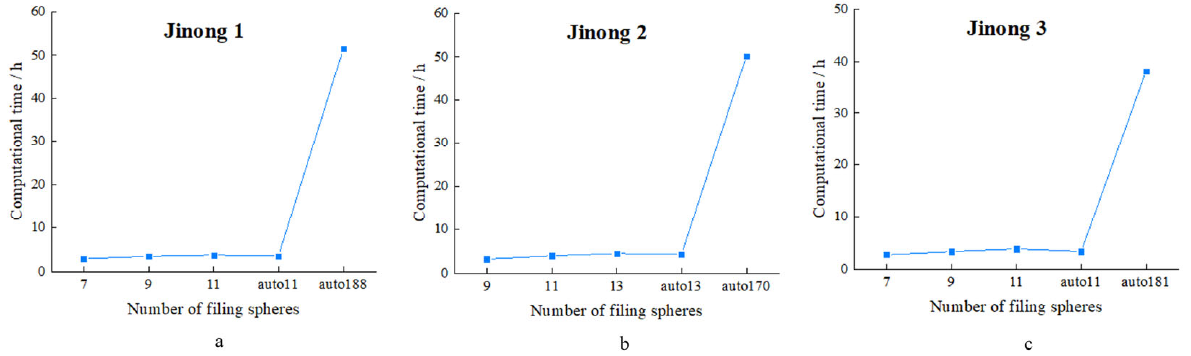
Figure 23. Computational times of the rotating hub test simulation.